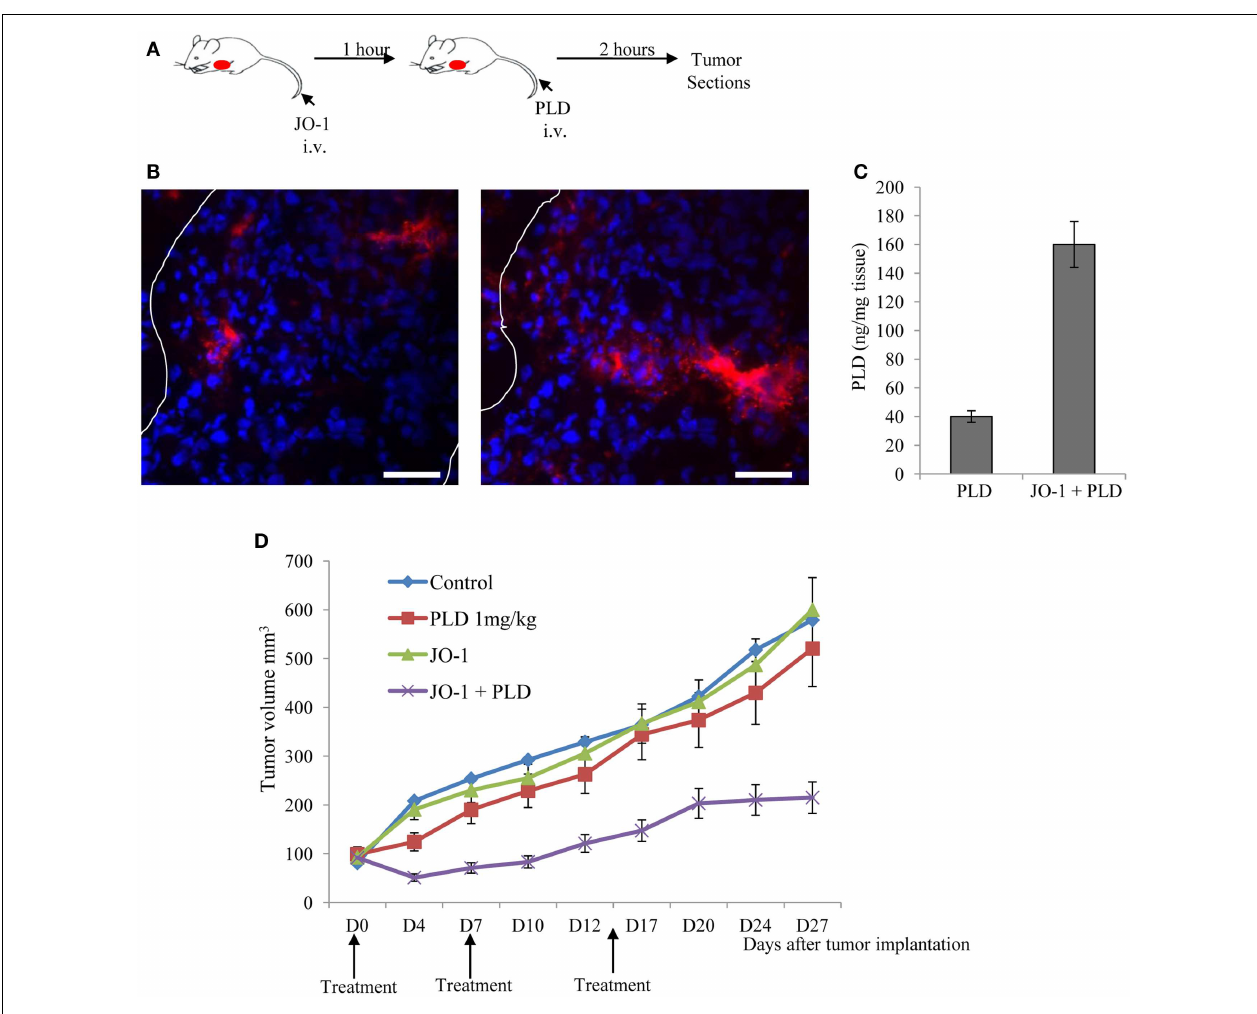
Immunofluorescence analysis for PLD on tumor sections with anti-PEG antibodies. PLT appears in red.The scale bar is 20 µ m. Notably, free PEG is poorly detected by ELISA or immunohistochemistry (184). (C) PLD concentrations in tumors measured by ELISA ( N = 3). (D) Therapy study in mice with ovc316 tumors.Treatment was started when tumors reached a volume of 100mm 3 (D0). Mice were injected intravenously with 2mg/kg JO-1 or PBS, followed by an intravenous injection of PLD (1mg/kg) or PBS 1h later.Treatment was repeated weekly ( N =